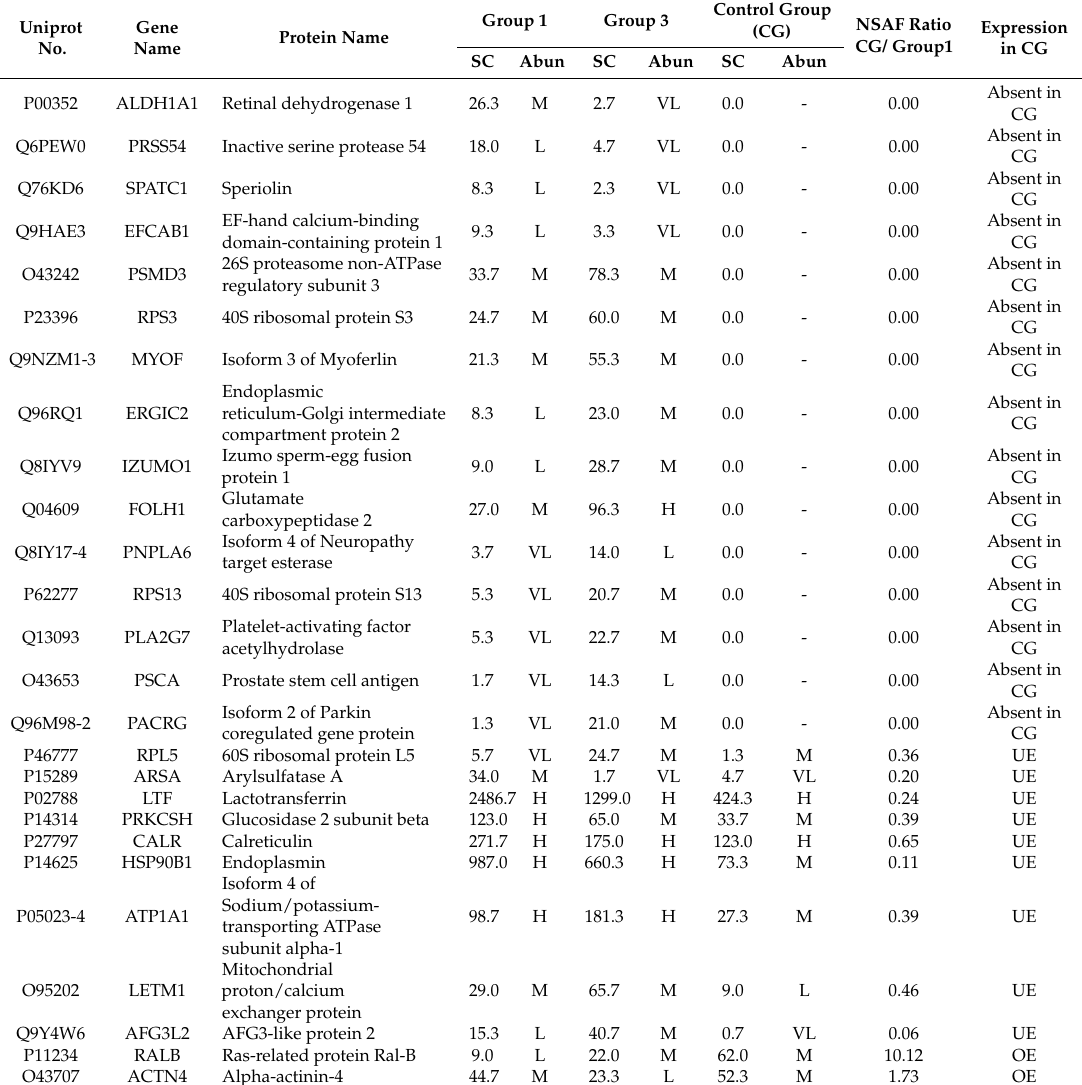
Table 3. Differentially expressed proteins and their abundance in semen samples from group 1 ( ≥ 1 × 10 6 /mL leukocytes), group 3 (round cells < 1 × 10 6 /mL), and control group (pure leukocyte